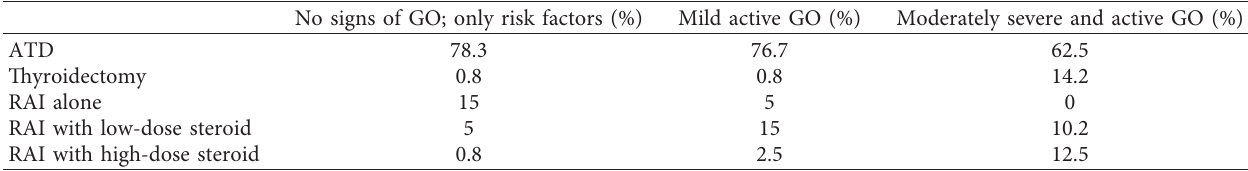
Abbreviation: ATD, antithyroid drug; GO, Graves’ orbitopathy; RAI, radioactive